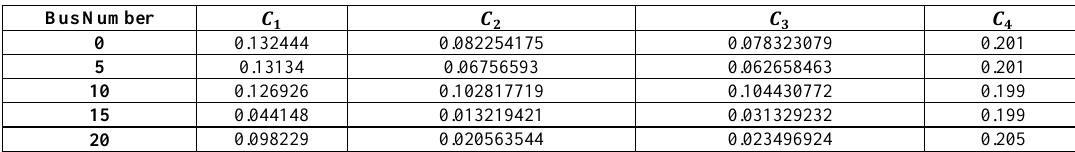
Table 4. Weighted decision matrix.